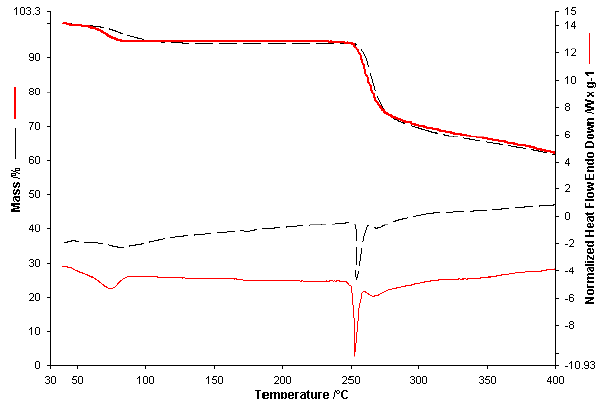
Figure 6 . The thermoanalytical curves of Av (SA)___ and Av (D)____ obtained with a heating rate of 10 °C ∙ min − 1 .